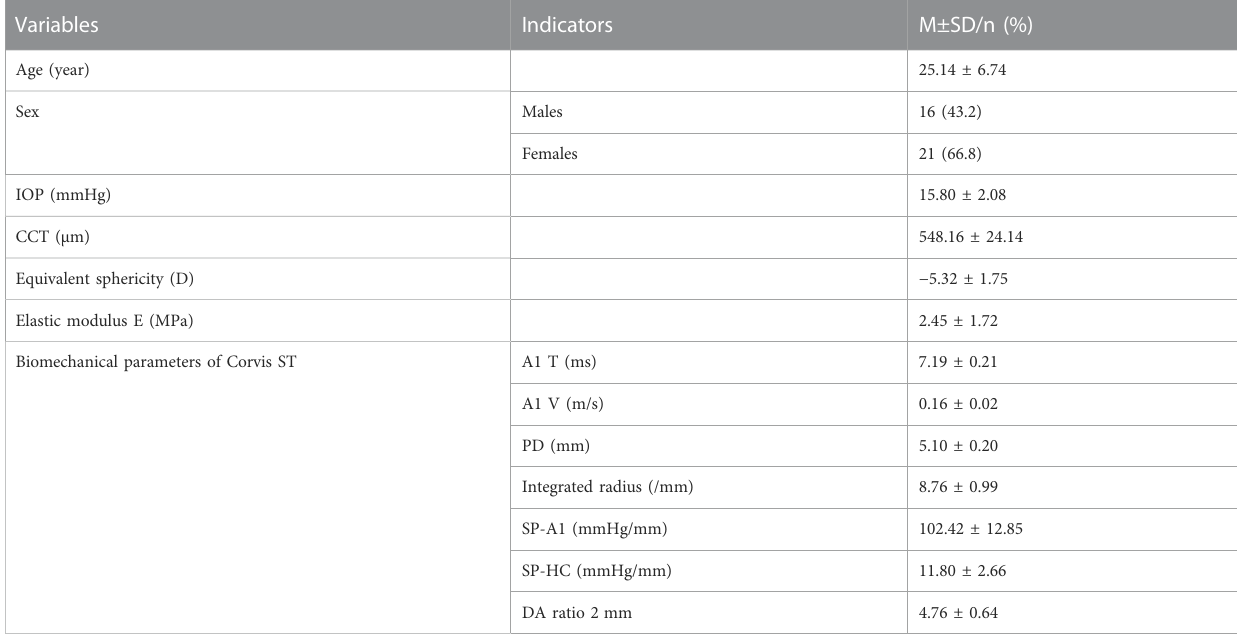
TABLE 1 Descriptive characteristics of 37 patients (63 eyes) with myopia.